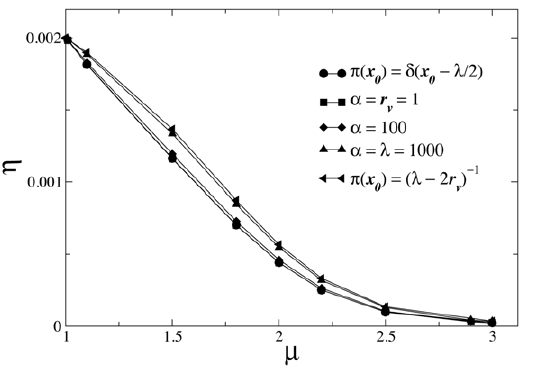
Figure 2. Shift in the optimal search strategy towards an enhanced superdiffusive dynamical regime, as landscapes with distinct degrees of heterogeneity are considered. For Le´vy random searchers, using l ~ 10 3 and r v ~ 1 (solid symbols), the average search efficiency g , Eq. (5), is maximized for smaller m opt ( a ) (faster diffusivity) in the case of wider (larger- a ) Poissonian fluctuations in the distances to nearby target sites, Eq. (4). Cases with uniform and without any ( d -function) fluctuation are also shown (solid lines are a visual guide). Empty symbols locate the maximum g obtained from the ~ 0 . For strong enough fluc- condition f ( m ~ m opt , a ) ~ LS L T p = L m j m ~ m opt tuations, with a w a cross & 312 : 2 , a crossover to ballistic dynamics ( m ? 1 ) emerges.